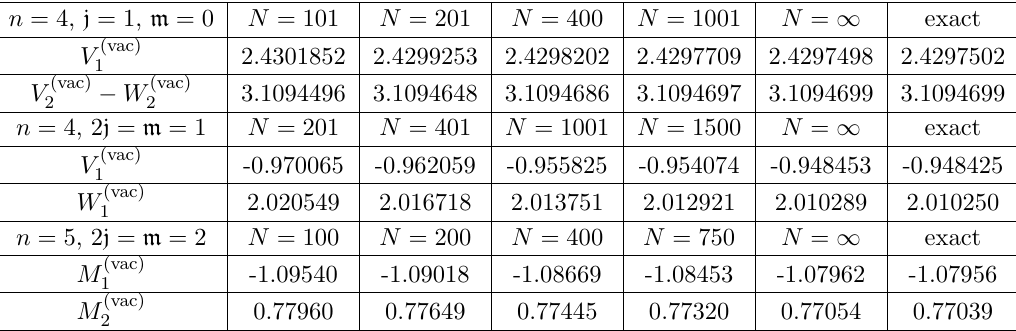
Table 7 . Numerical values of the coe(cid:14)cients (B.7), (B.8) for the vacuum of the Fateev- Zamolodchikov spin chain (3.47), (3.48). The column N = 1 was obtained by interpolating